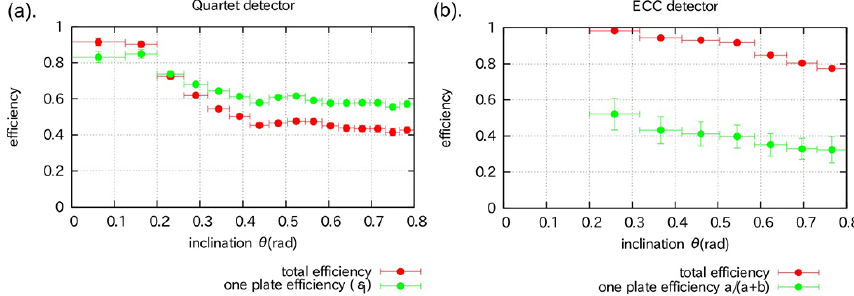
Fig. 8. Efficiency of signal detection as a function of track inclination θ for the quartet detector (a) and ECC detector (b) . The green circles show the efficiency for a single film and the red circles show the total efficiency values (cid:15) Q, ECC